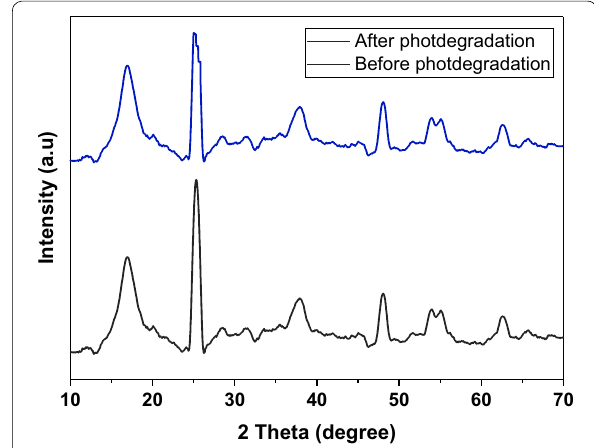
Fig. 8 XRD patterns of PAN-CNT/TiO 2 –NH 2 composite nanofibers before and after the photocatalytic